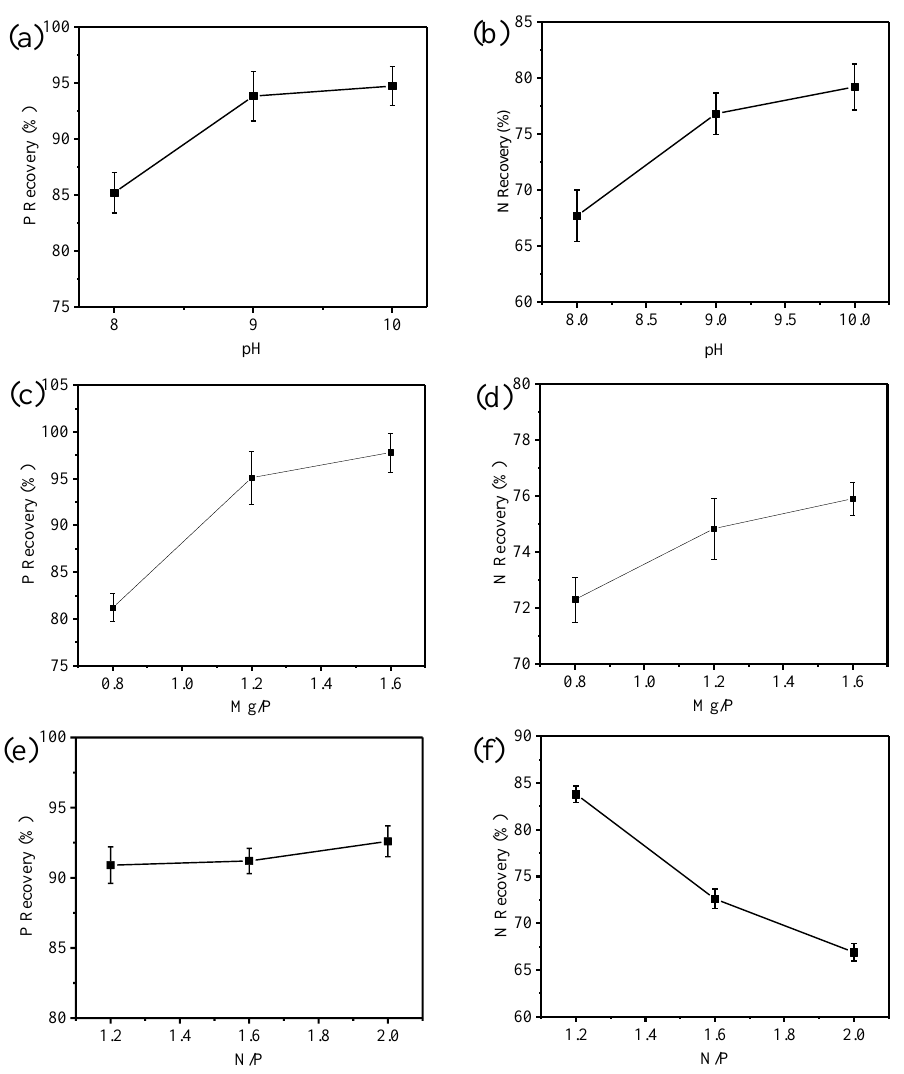
Figure 2. Effect of pH ( a , b ), Mg/P ( c , d ) and N/P ( e , f ) on the recovery of P and N, respectively.